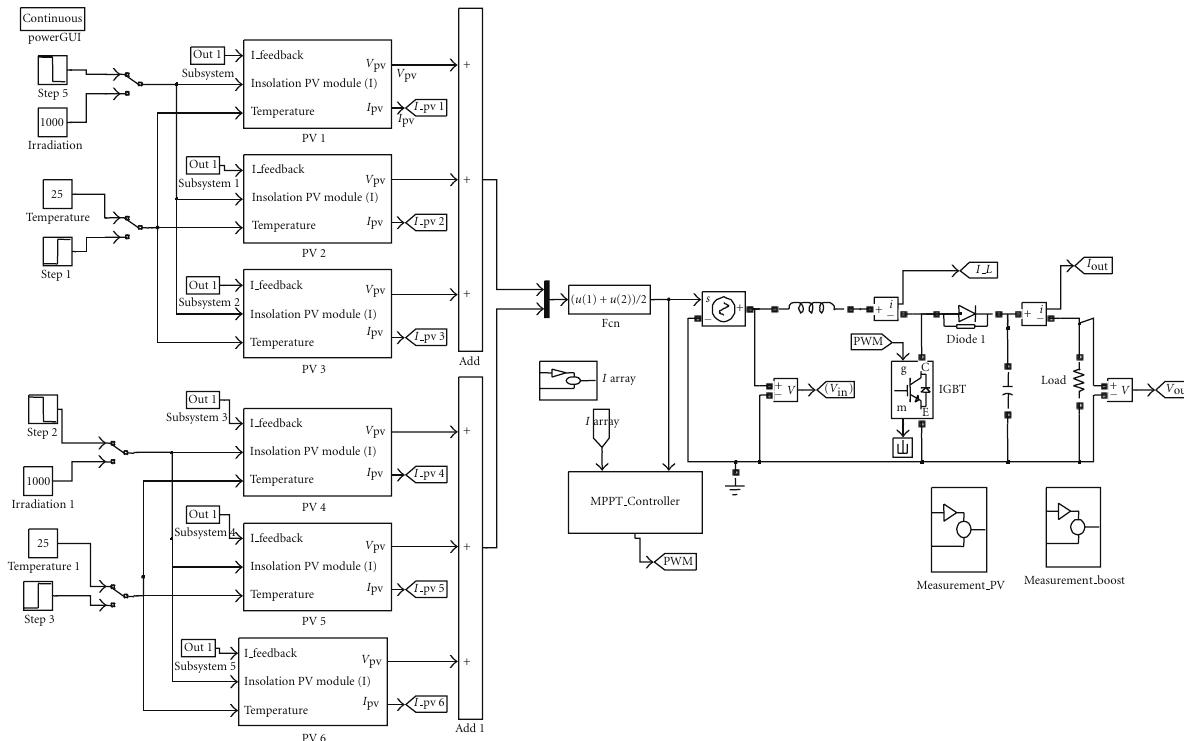
Figure 9: MATLAB simulation model of a PV MPPT controller.